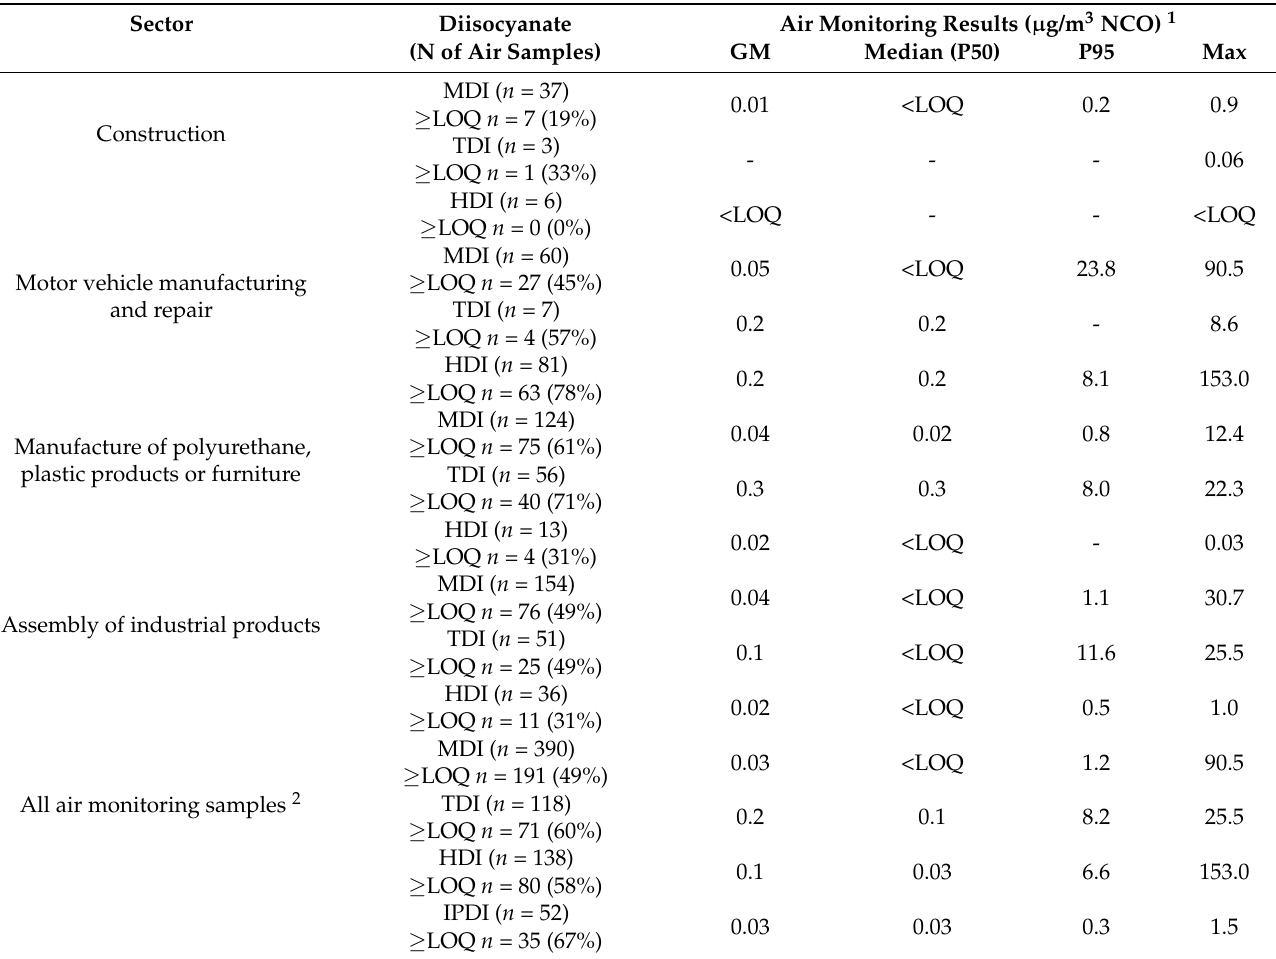
Table 3. Diisocyanate air monitoring data measured in breathing zones of workers in specific sectors from Finnish occupational studies in